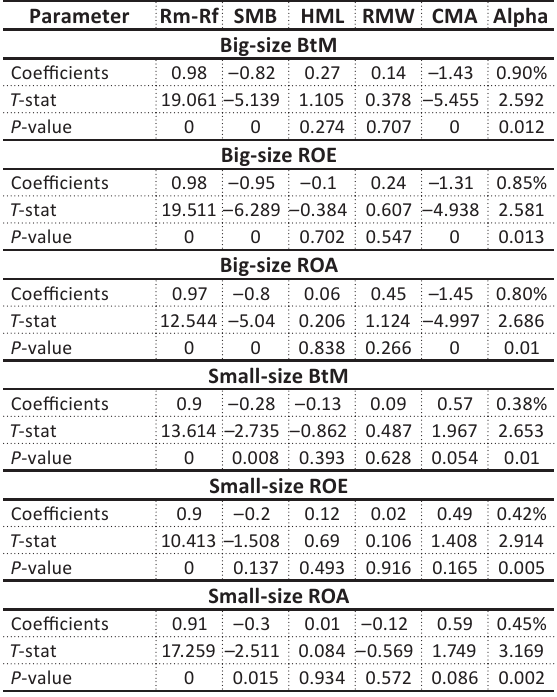
Table 4. Parameter estimates of the FF5F